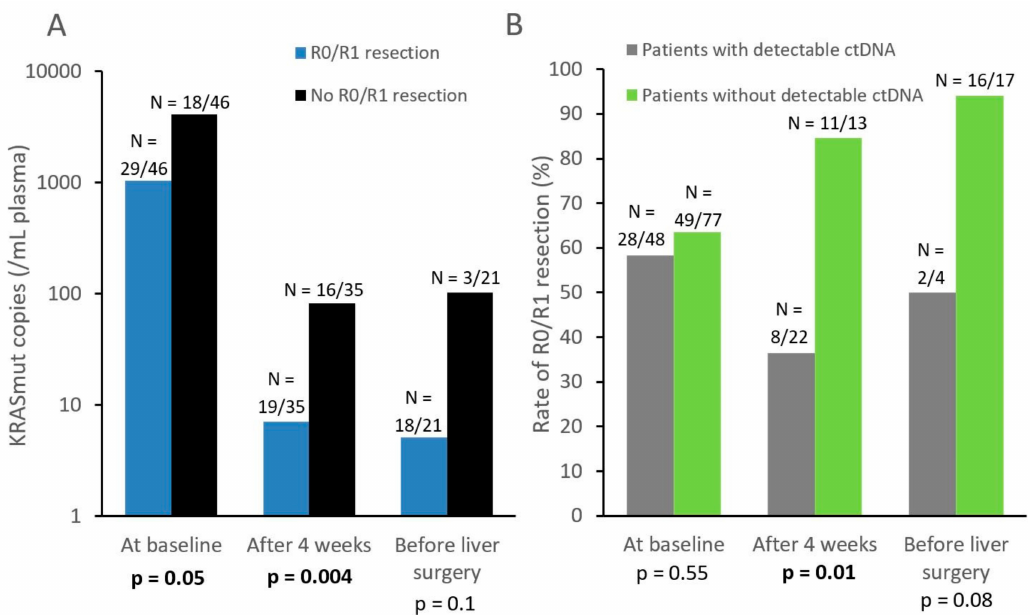
Figure 4. ( A ) Mean number of KRASmut copies per mL of plasma (continuous variable) at baseline, after four weeks, and before LM resection. N indicates the number of patients who achieved or did not achieve R0 / R1 resection, among patients (with a KRAS mutated tumor) available for KRASmut assessment at each time point. ( B ) Rate of R0 / R1 resection for patients with or without detectable ctDNA (dichotomized variable). N indicates the number of patients who achieved R0 / R1 resection according to their ctDNA detection status, among patients who underwent the ctDNA detection assay at each